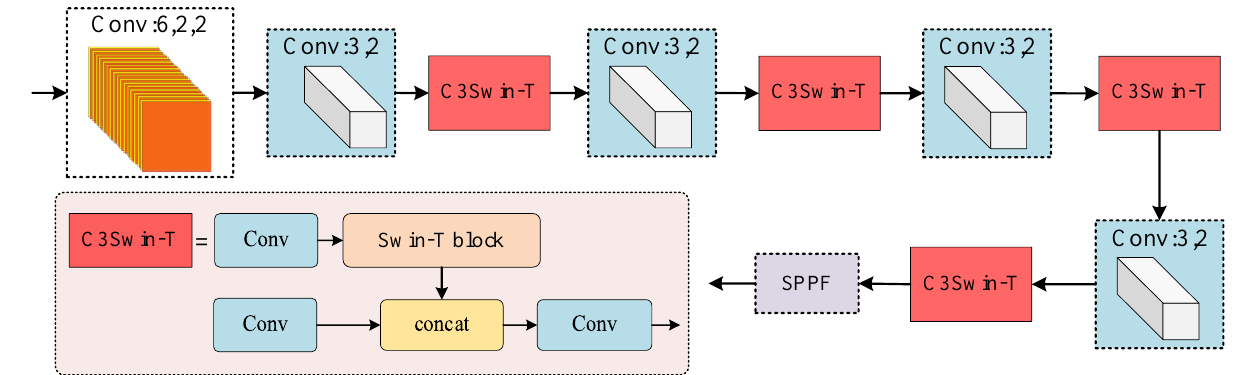
Figure 7. The structure of Swin-T block.